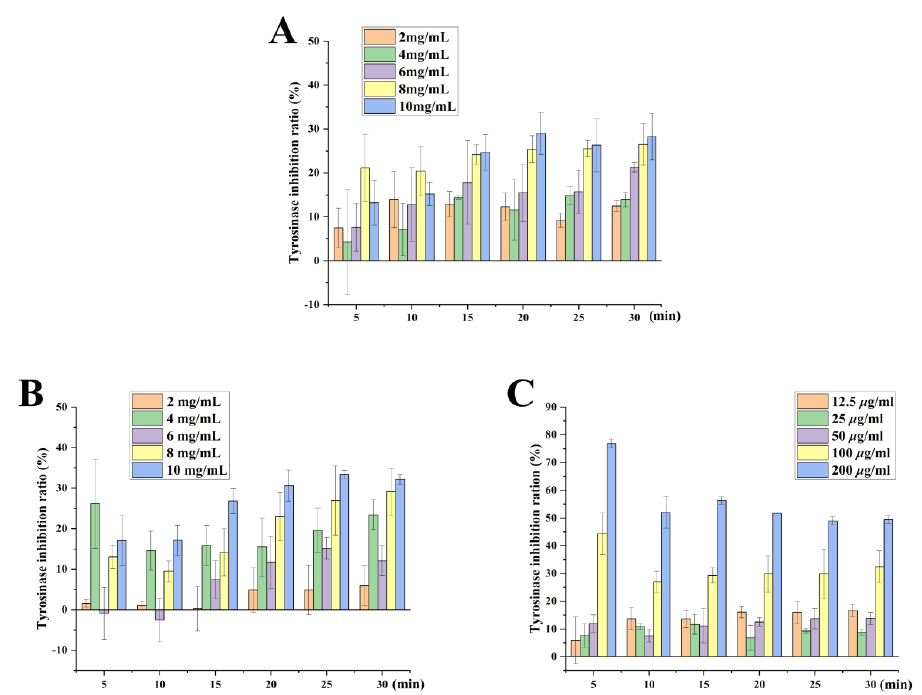
Figure 8. Inhibitory effect of NC89 and BS4 seed oils with different concentrations on tyrosinase in different times. Mushroom tyrosinase was treated with NC89 ( A ), BS4 ( B ), Vitamin C ( C ), and tyrosinase activity was measured. Values are presented as the mean ± SD ( n = 3).